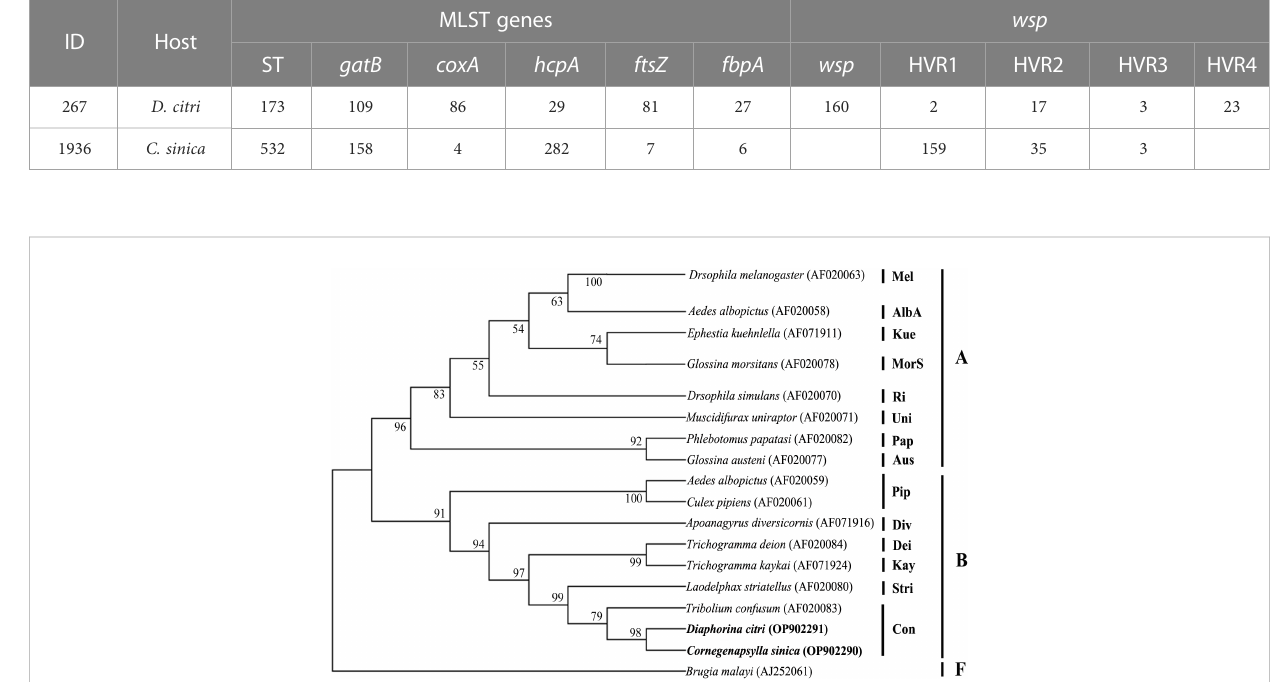
FIGURE 3 The phylogenetic relationships of Wolbachia from different insect hosts based on the DNA sequence of wsp gene. The tree was constructed and analyzed by Neighbor-Joining (NJ) method using 1000 bootstraps replicates.